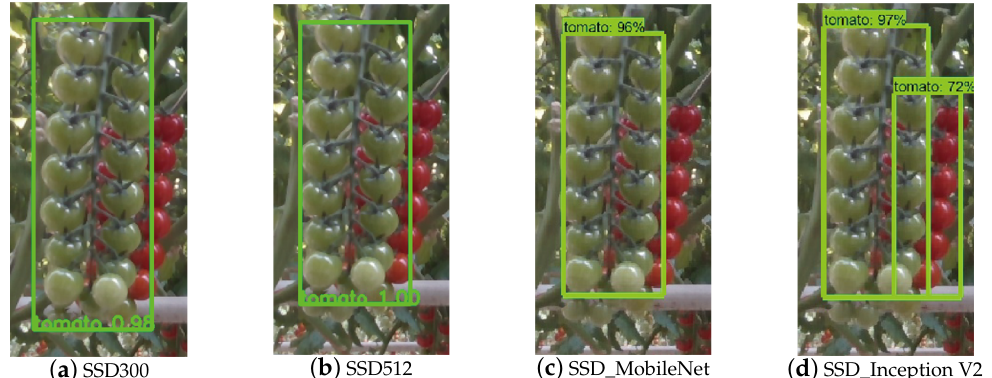
Figure 9. The detection results of overlapped cherry tomatoes. ( a ) the result of SSD300 model, ( b ) the result of SSD512 model, ( c ) the result of SSD_MobileNet model and ( d ) the result of SSD_Inception V2